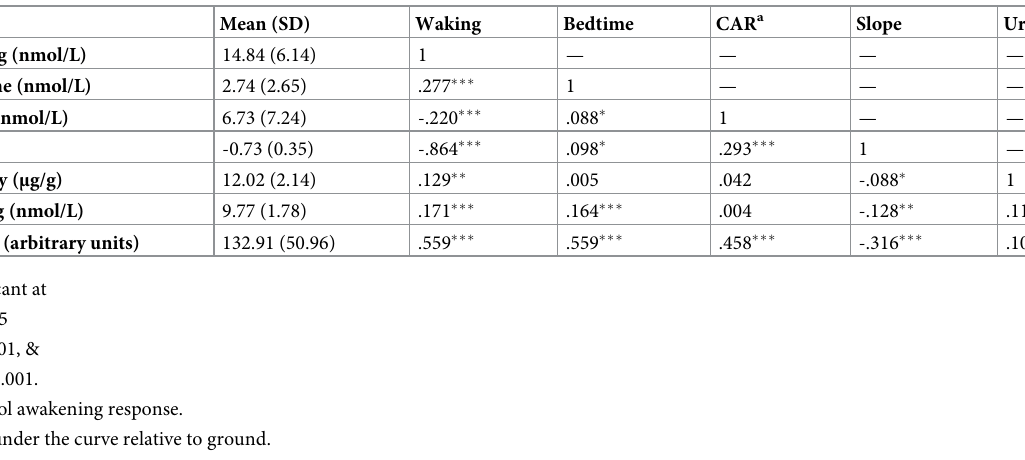
Table 3. Means of and zero-order correlations between cortisol indices (N =